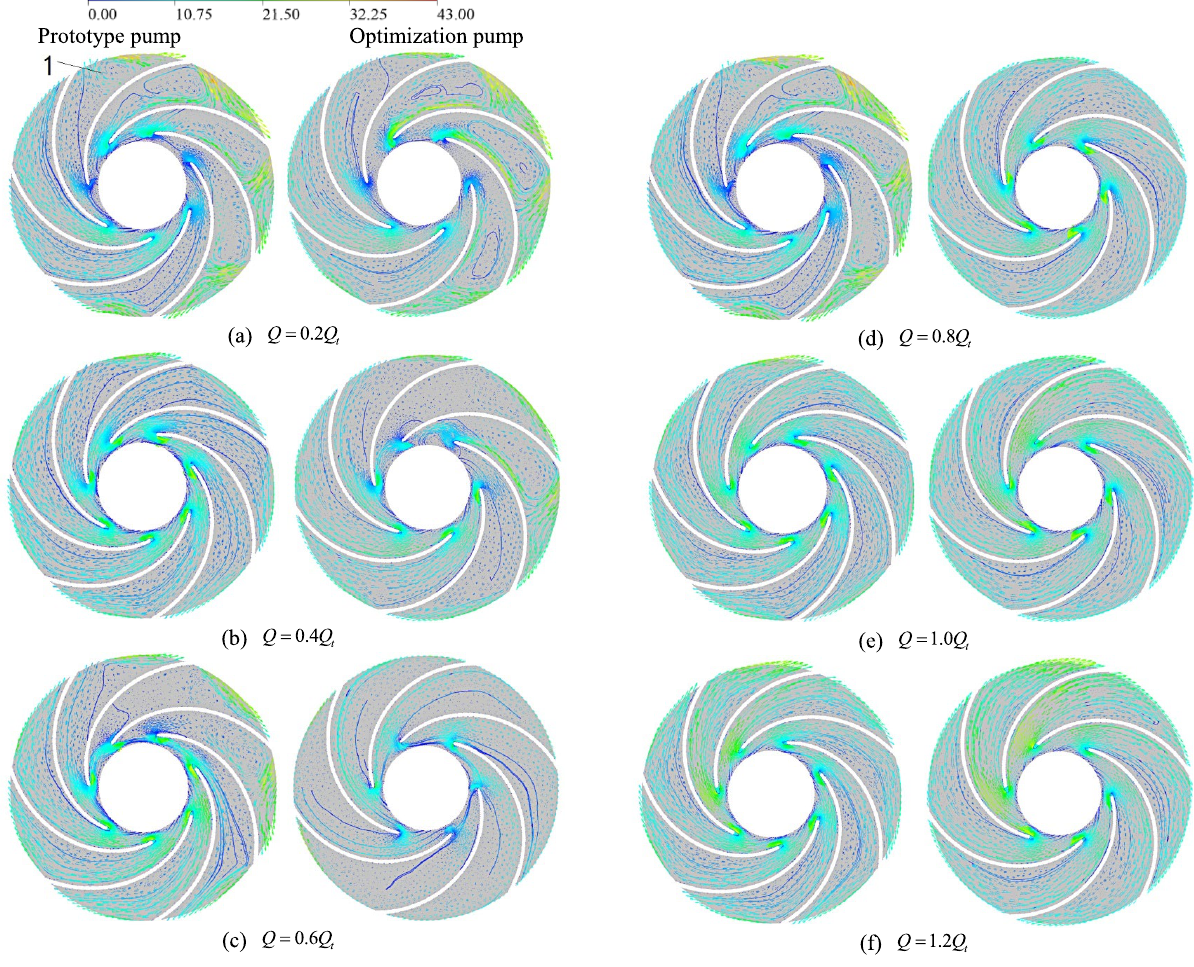
Figure 4. The relative velocity distribution at the intermediate interface of centrifugal